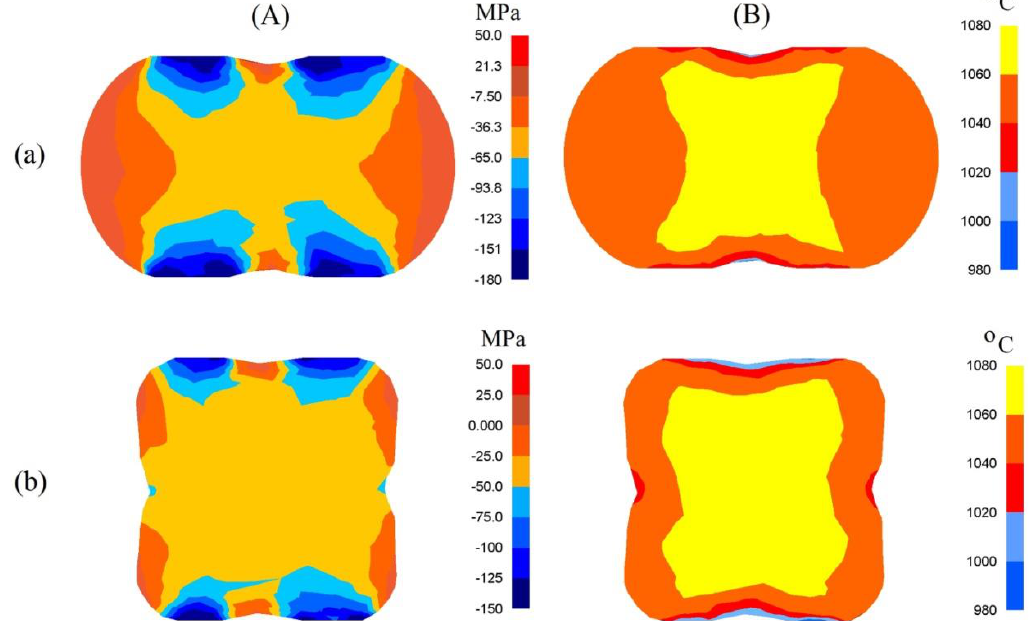
Figure 6. Distribution of mean stresses ( A ) and temperature ( B ) after the cogging process in convex anvils with an angle of 130°: ( a ) after first pass; ( b ) after the second pass (reduction ratio 0.70) .